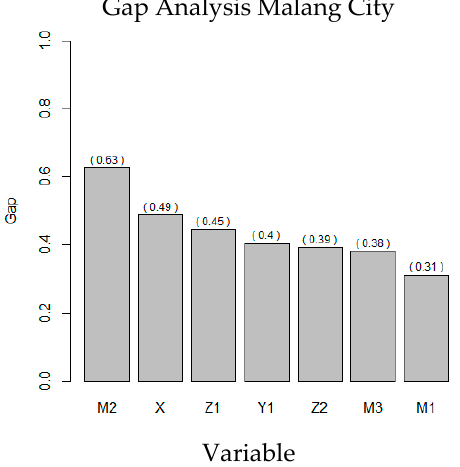
Figure A3. Bar Diagram of Gap Analysis of Malang City.